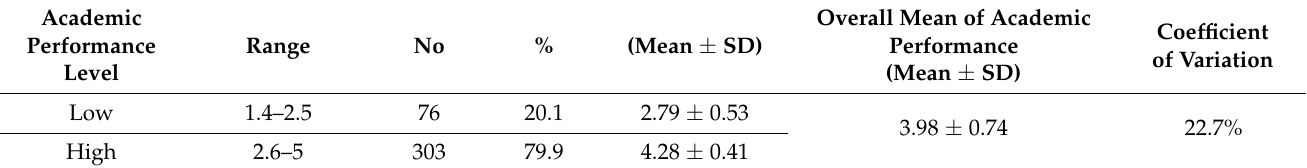
Table 3. Academic performance level among the study participants (n = 379).